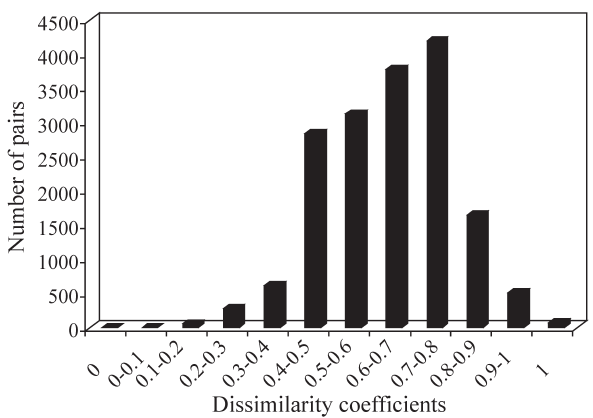
Figure 1 - Distribution of genetic distances calculated for 17,205 pairs of genotypes.